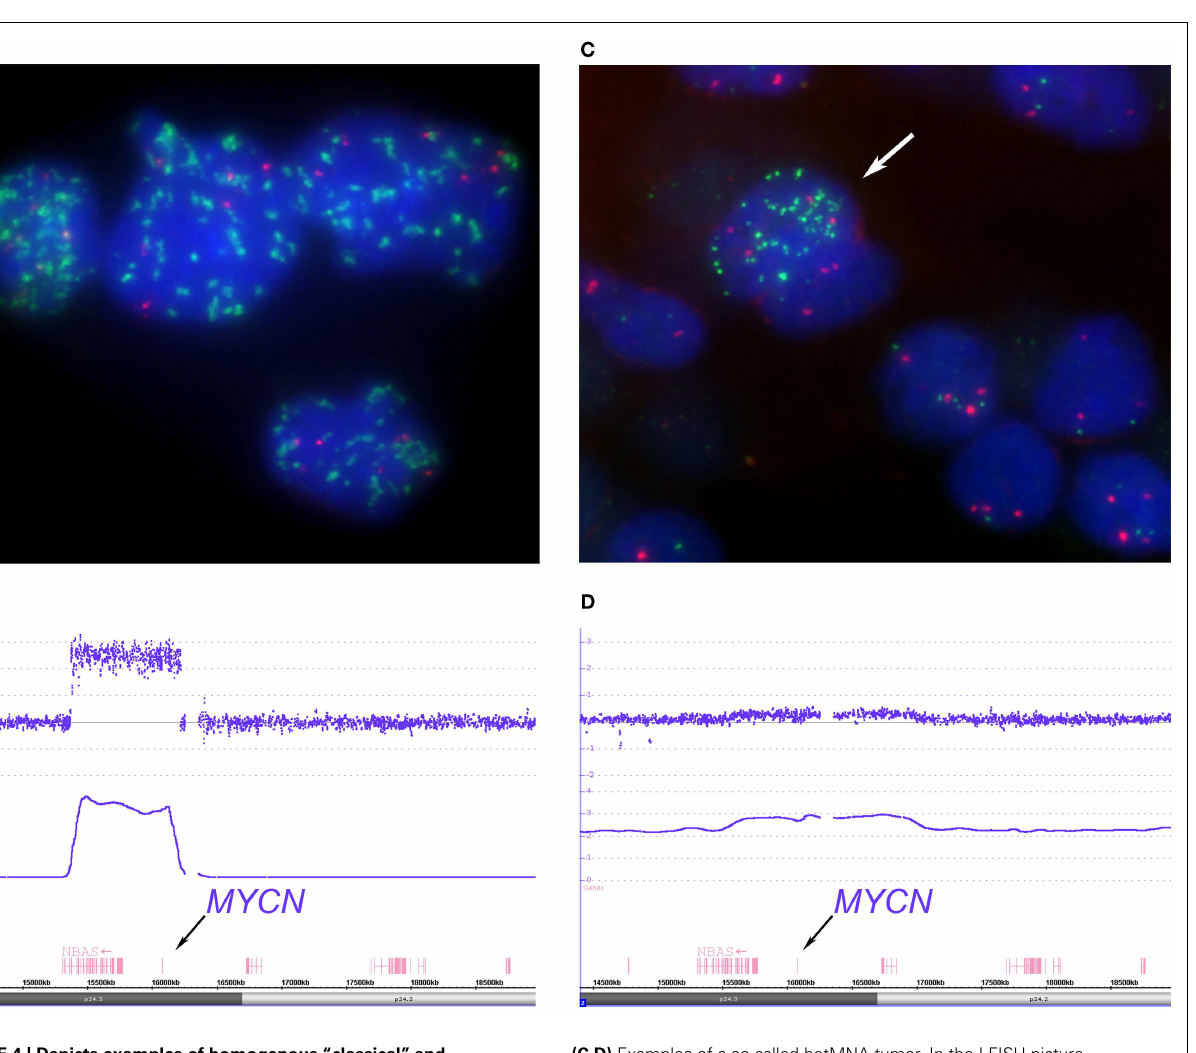
FIGURE 4 | Depicts examples of homogenous “classical” and heterogeneous MYCN amplified tumors .The FISH picture, (A) ( MYCN FISH probe in green, 2p probe in red), shows tumor cell nuclei with a varying number of MYCN signals ranging from approximately 30 signals up to hundreds distributed randomly within the nuclei.The large size of some of the MYCN hybridization spots can be explained by repeated amplicon units.The SNParray profile of a segment of the short arm of chromosome 2 from a homogeneously amplified neuroblastoma is given in (B) which shows a clear peak for the MYCN locus (copy number